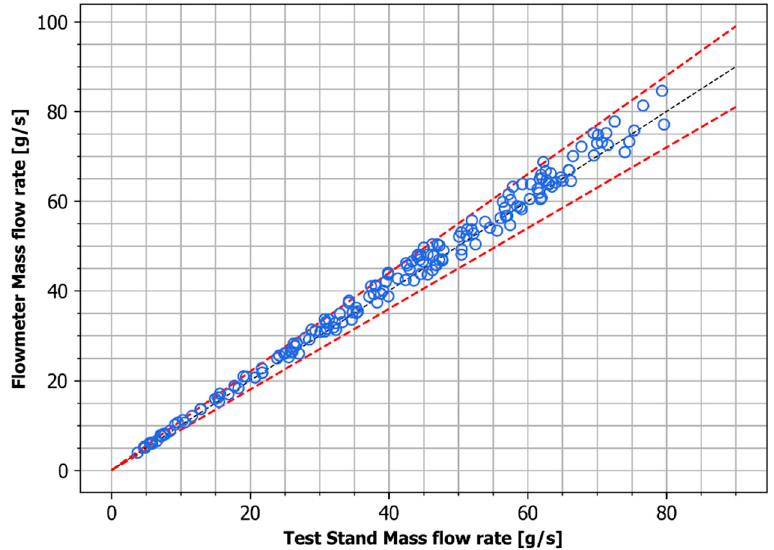
Figure 3. Comparison of the mass flow rate measured using the test stand to that measured using the Coriolis flowmeter. The measured mass flow rate is within ±10% of the actual (given by the flowmeter).